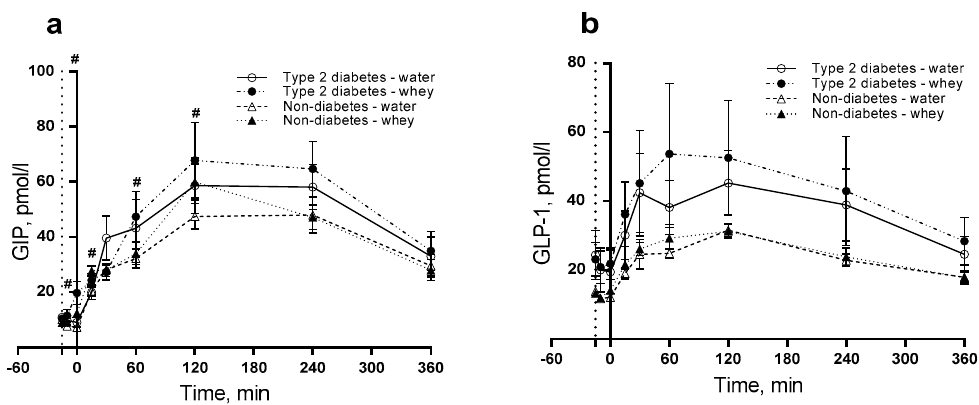
Figure 3. Postprandial responses for glucose-dependent insulinotropic peptide (GIP) ( a ) and glucagon-like peptide 1 (GLP-1) ( b ). 12 T2D and 12 non-diabetic subjects were observed after consumption of 20 g whey proteins (WP) or water as a pre-meal 15 min prior to a fat-rich meal. Dotted vertical line (y = − 15) indicates pre-meal consumption. Data are presented as mean ± SEM, n = 24. # indicates differences between pre-meals (WP and water). ANOVA for repeated measurements was used to examine the effect of diabetes, intervention and time on the postprandial responses.